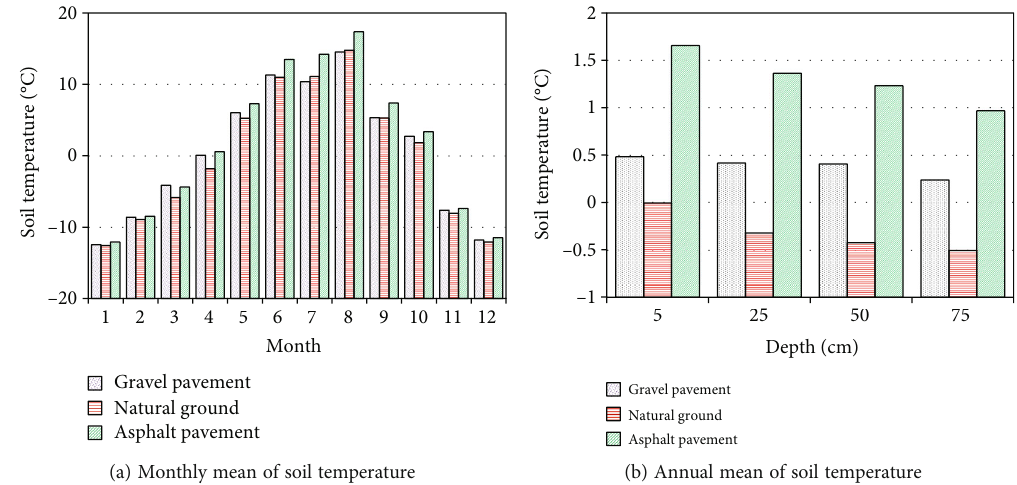
Figure 8: The temperature variation in soil under di ff erent underlying